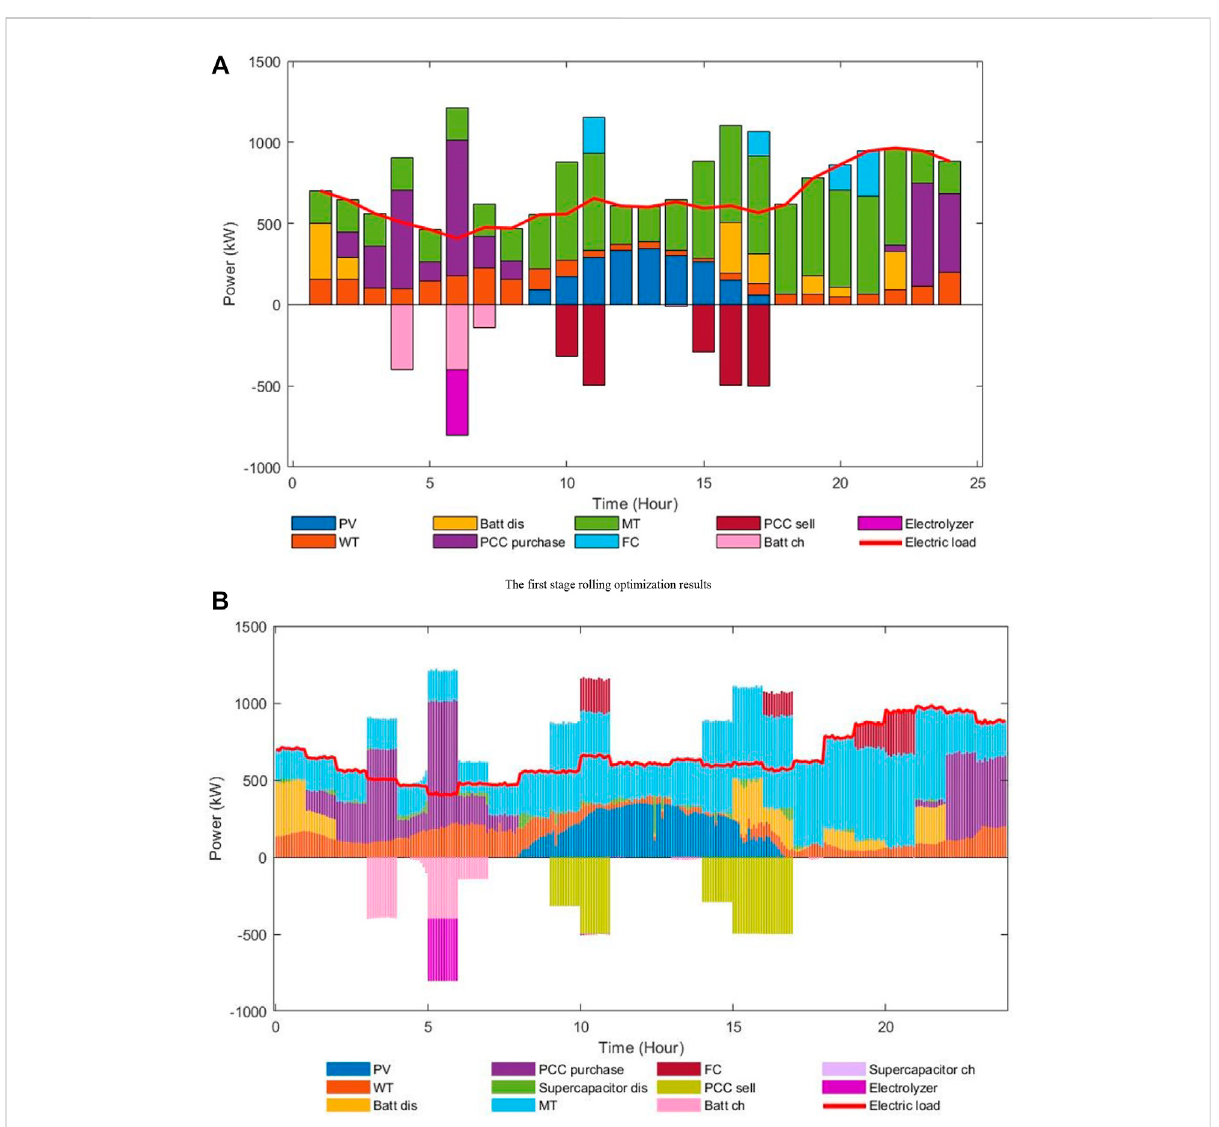
FIGURE 5 Winterelectricoptimizationresults ofMPCrolling optimizationlayer. (A) The fi rst stagerolling optimization results. (B) The second stagerolling optimization results.